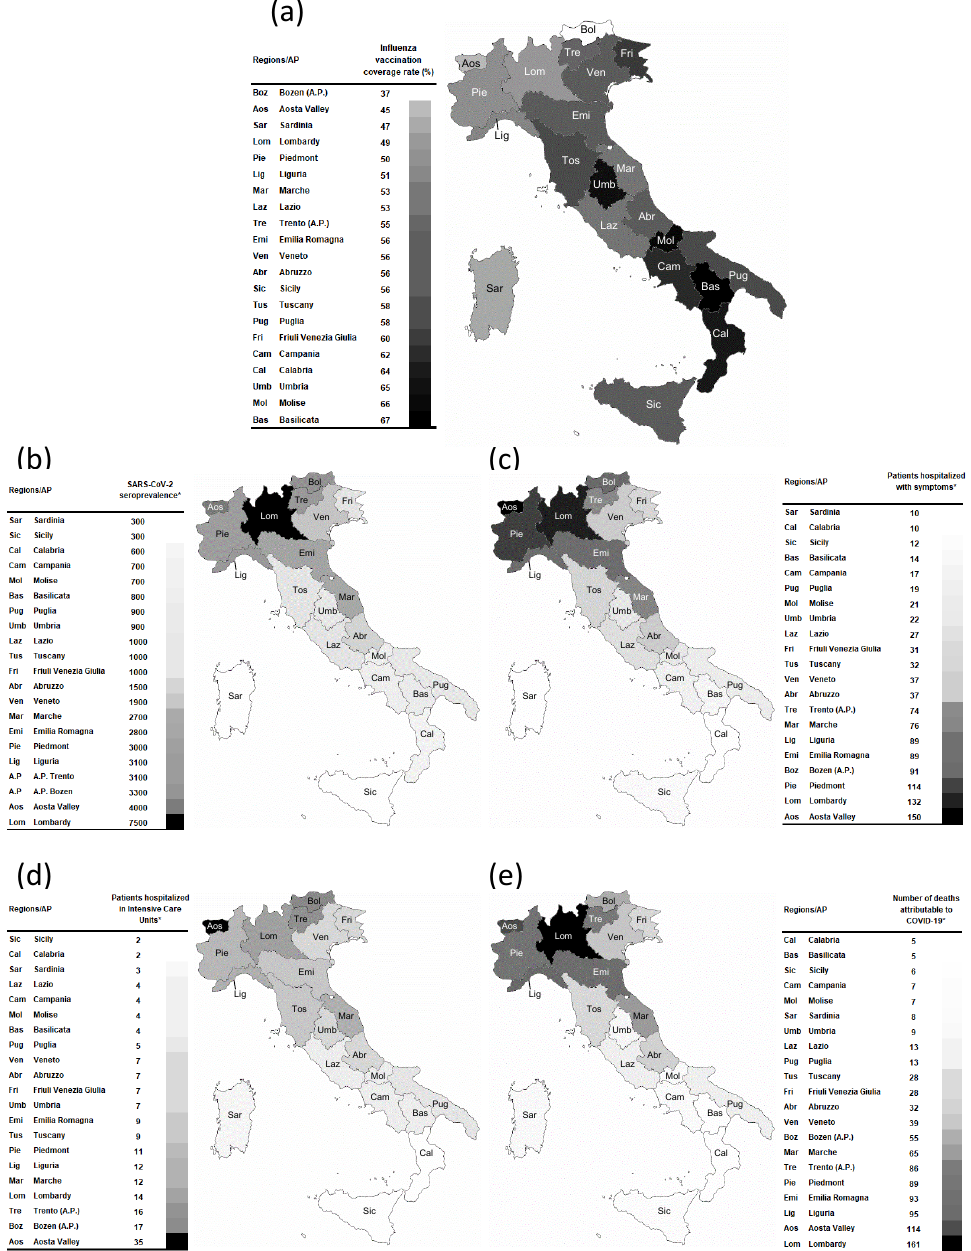
Figure 1. ( a ) Influenza vaccination coverage rate, ( b ) seroprevalence for COVID-19, ( c ) patients hospitalized with symptoms, ( d ) patients hospitalized in intensive care units, and ( e ) number of deaths attributable to COVID-19 in the regions / AP. * cases / 100,000